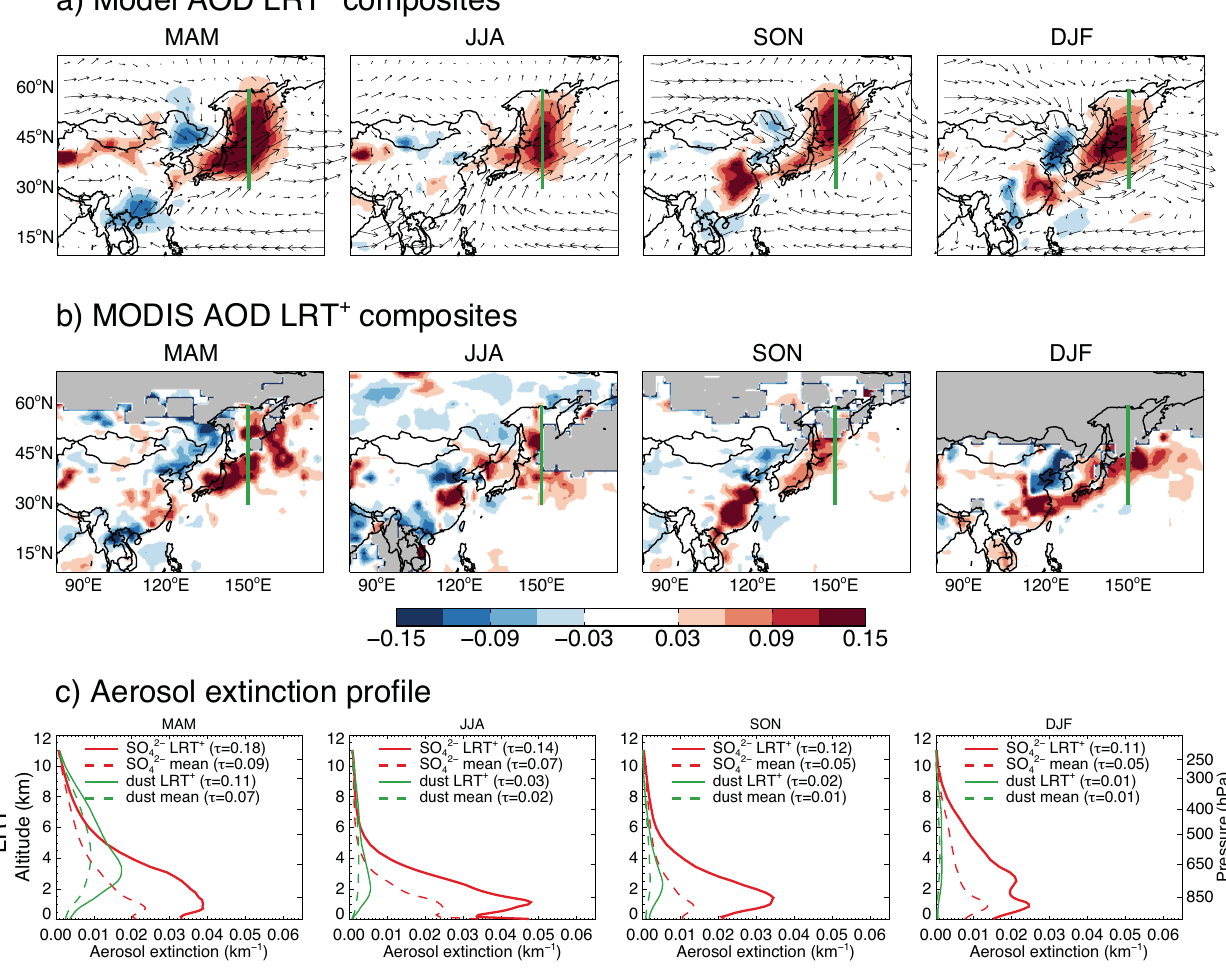
Fig. 4. Seasonal composites of AOD anomalies (defined as the difference between the AOD on LRT + days and the seasonal mean AOD) and extinction profiles over the NW Pacific Ocean on LRT + days. From left to right: spring (MAM), summer (JJA), fall (SON), and winter (DJF). (a) GEOS-Chem AOD anomalies (filled contours) with 850hPa wind fields (arrows). The green line (150 ◦ E, 30 ◦ –60 ◦ N) indicates the wall defining our Asian outflow timeseries. (b) MODIS AOD anomalies. The grey color represents missing data or cloudy conditions in the MODIS observations. (c) GEOS-Chem extinction profiles of sulfate (red) and dust (green) at 150 ◦ E, 30 ◦ –60 ◦ N. The dashed lines indicate the seasonal average, while the solid lines correspond to mean profiles on LRT + days. The mean values for the AOD are indicated in the figure